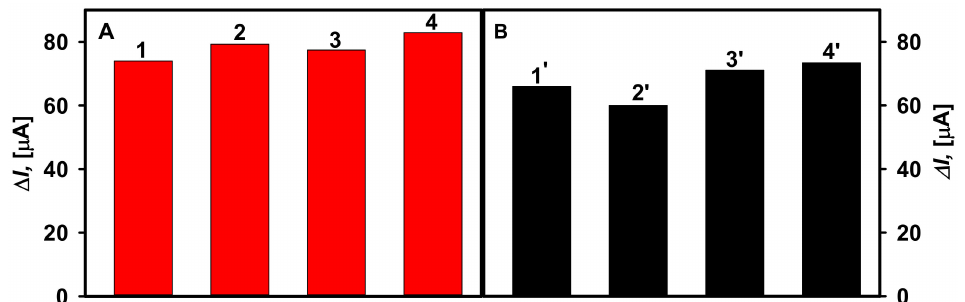
Figure 7. The effect of interfering substances on the current response of the glucose biosensors developed based on GA-GOx-SAM/DGNs/GR ( A ) and GA-GOx/DGNs/GR ( B ) electrodes. Dia- grams of the registered current response are presented after addition of: 10 mM solution of glucose (column 1, 1 (cid:48) ), 10 mM solution of glucose with 0.1 mM uric acid (column 2, 2 (cid:48) ), 10 mM solution of glucose with 0.01 mM ascorbic acid (column 3, 3 (cid:48) ), and 10 mM solution of glucose with 0.05 mM ascorbic acid (column 4, 4 (cid:48)